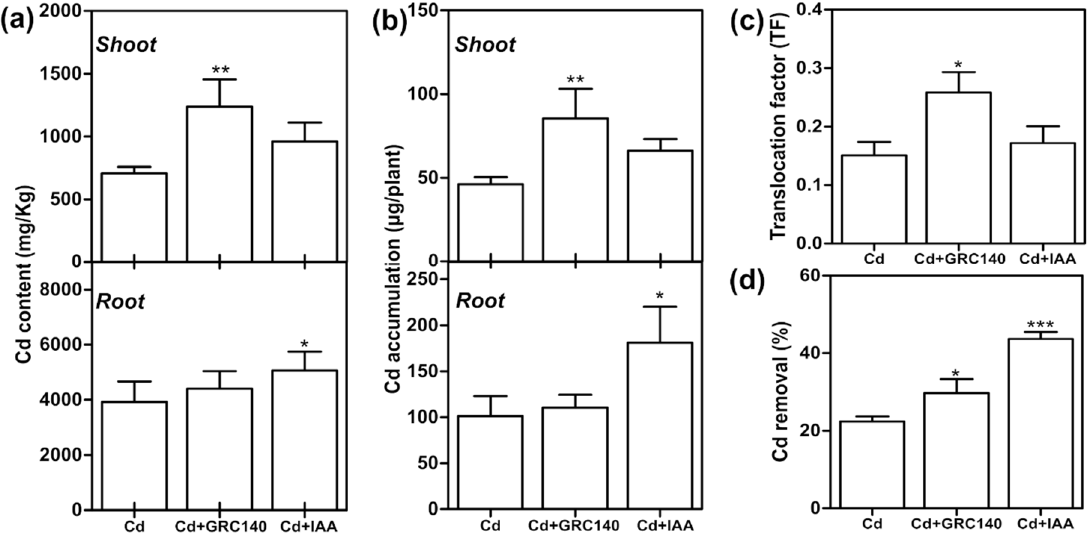
Figure 6. Effect of P. rhodesiae GRC140 and IAA on Cd content and Cd accumulation of T. latifolia . The values represent the mean ± SD ( n = 3). Asterisks indicate significant differences between control (Cd) and treatment (Dunnett’s test; * p < 0.05, ** p < 0.01 and *** p < 0.001). ( a ) Cd content, ( b ) Cd accumulation, ( c ) translocation factor, ( d ) Cd removal.